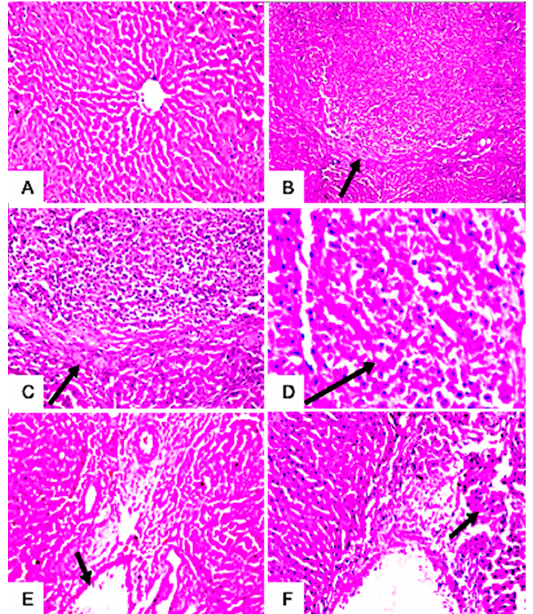
Figure 7. Histological changes in the liver tissues of male albino rats treated with the combined Alternaria mycotoxins (ALT, AOH, TeA, and AS); no histopathological alteration and the normal histological structure of the central vein and surrounding hepatocytes in the lobules of the parenchyma ( A ); focal circumscribed round granuloma-like formation consisting of mononuclear leucocytes and eosinophils cells surrounded by fine fibroblastic cell proliferation (black arrow) ( B – D ); the portal area showed dilations in the portal vein and inflammatory cell infiltration (black arrow) ( E , F ).